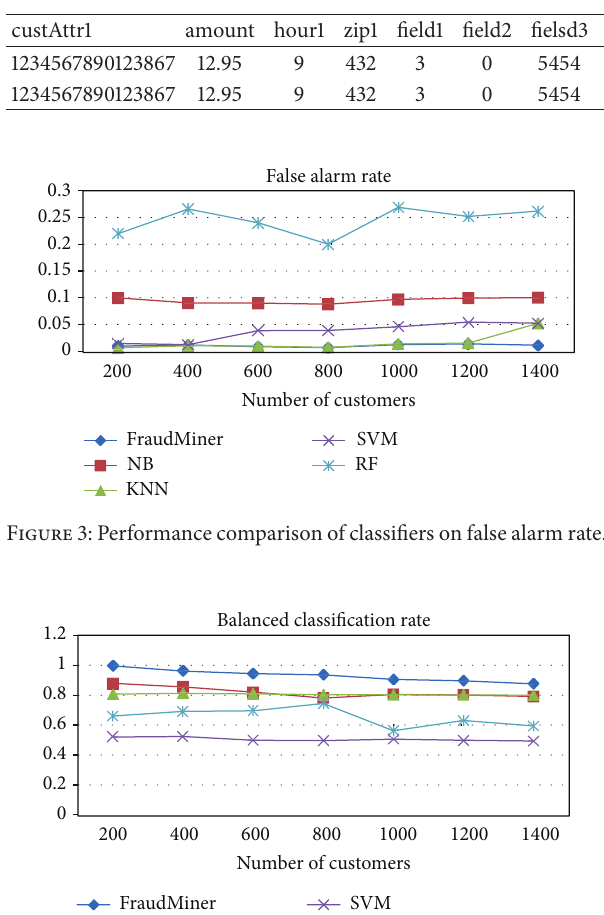
Table 2: Overlapped dataset.